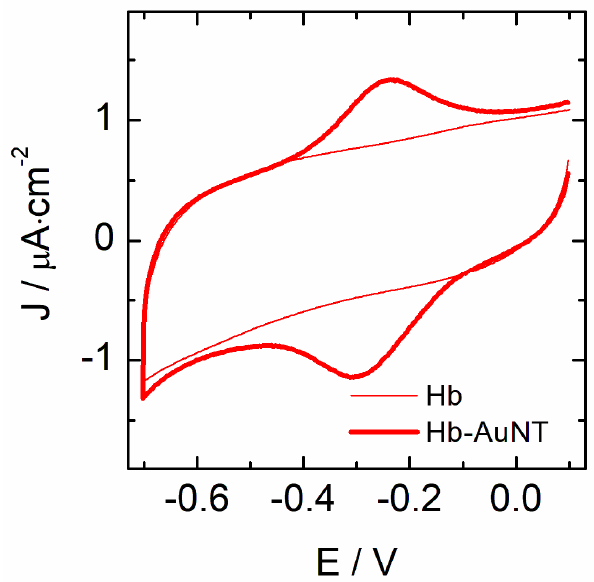
Figure 1. Cyclic voltammograms of Hb and Hb-AuNTs drop casted on a GC electrode in a 10 mM phosphate buffer at pH 7.4 (scan rate 0.1 V/s).